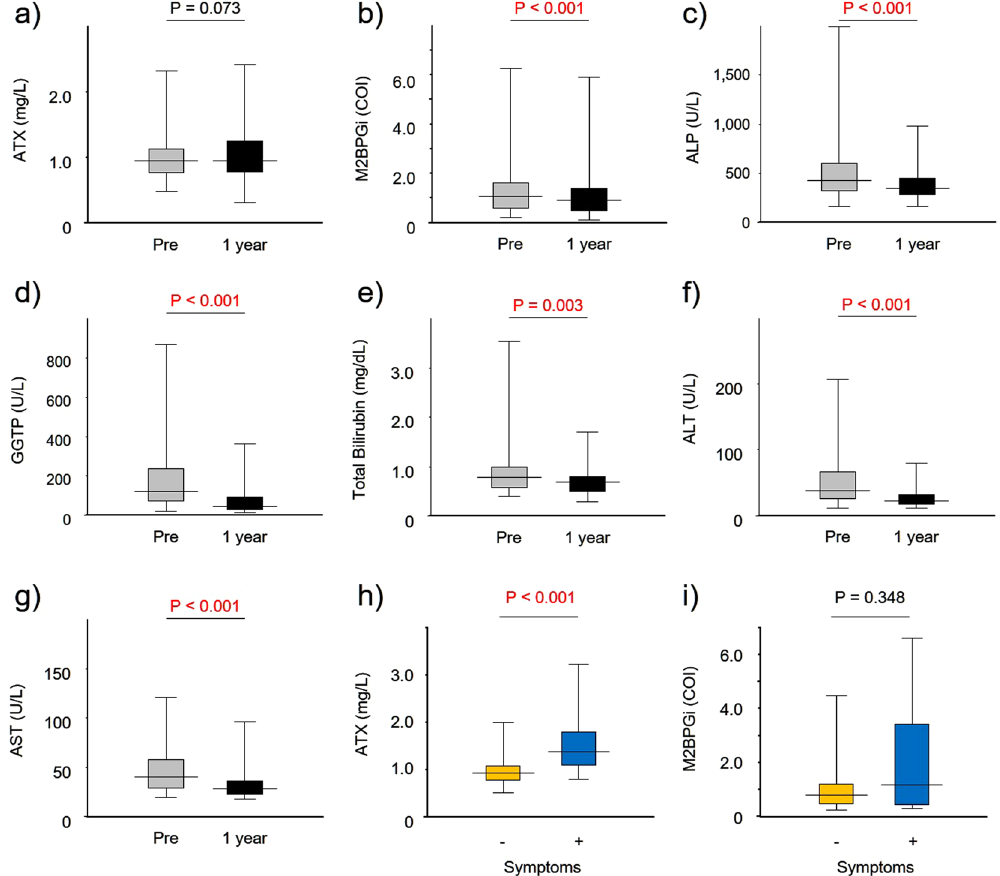
Figure 3. ( a – g ) Comparison of clinical parameters at diagnosis (Pre) and at 12 months of treatment with ursodeoxycholic acid (1 year). ( h , i ) Comparison of ATX and M2BPGi levels between asymptomatic and symptomatic patients at diagnosis. Abbreviations: ATX, autotaxin; M2BPGi, Wisteria floribunda agglutinin- positive Mac-2-binding protein; ALP, alkaline phosphatase; GGTP, gamma-glutamyl transpeptidase; ALT, alanine aminotransferase; AST, aspartate aminotransferase, − , asymptomatic patients; + , symptomatic